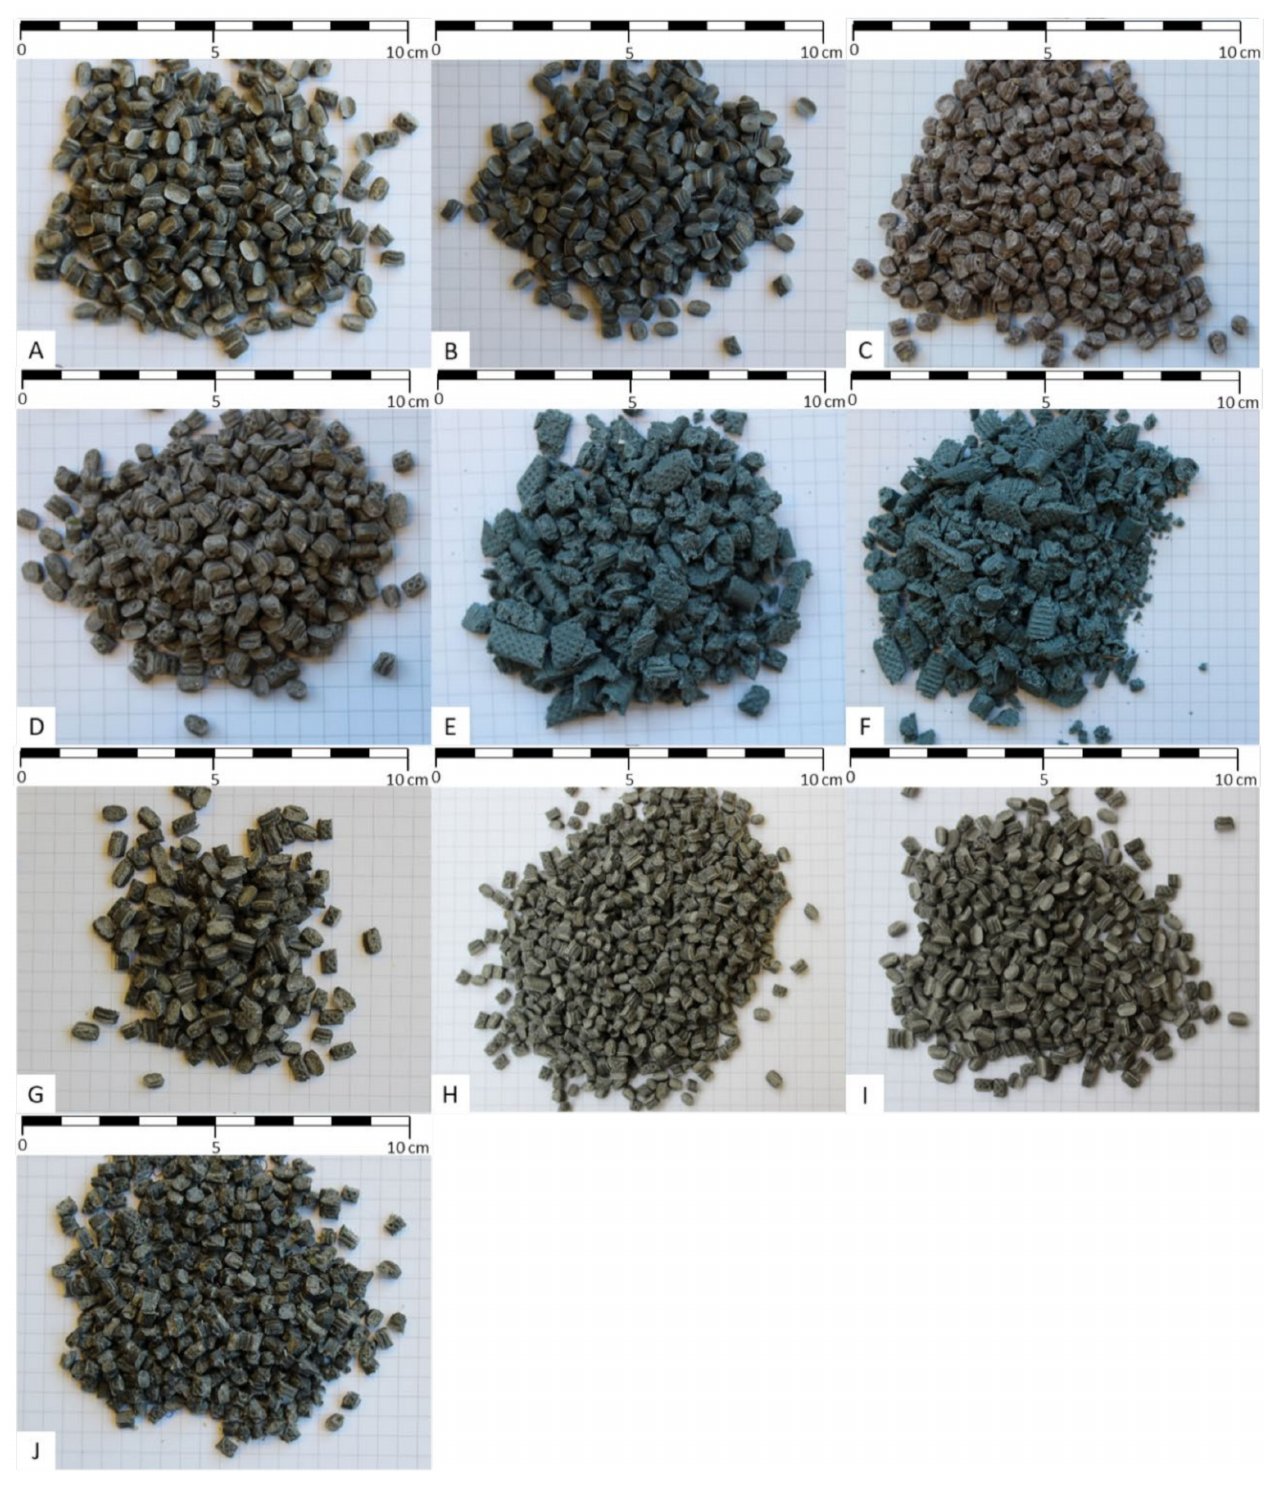
Figure A6. Exemplary photos of the granulates of all investigated materials after homogenisation and pelletising: P_C,PE— A ; P_W,C,PE— B ; P_PP_C— C ; P_W,C,PP— D ; P_C,PS— E ; P_W,C,PS— F ; PO_A,C— G ; PO_W, C , A–H ; PO_B, C—I ; and P_C— J